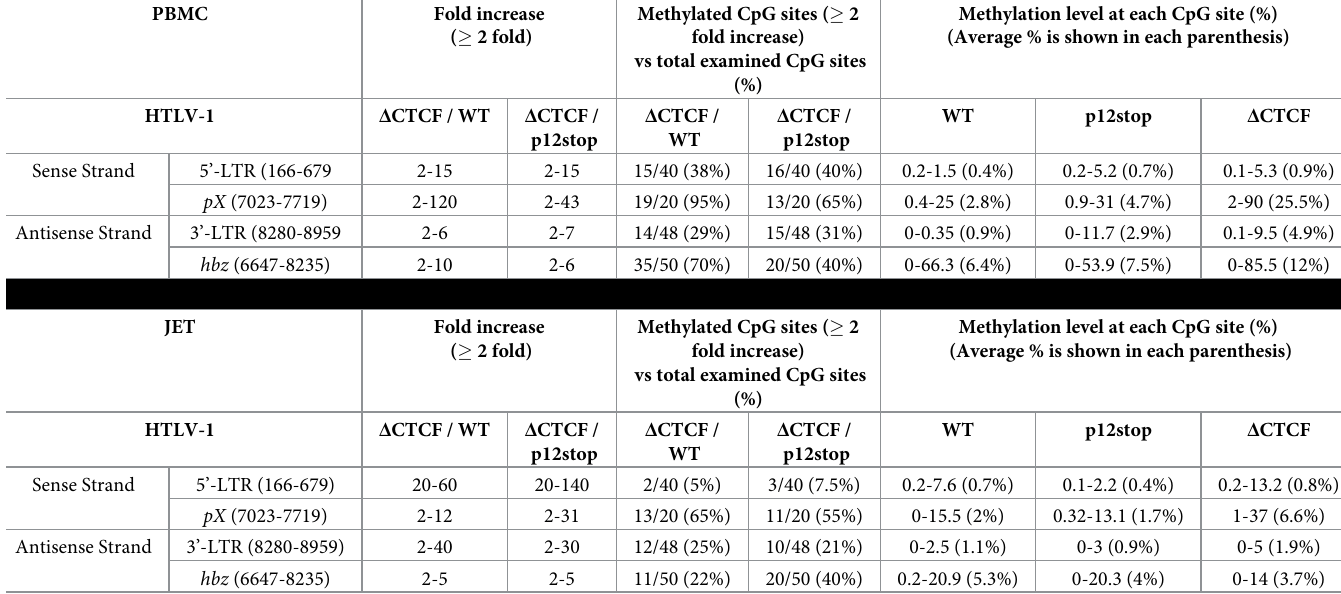
Table 1. Summary of increased methylation in 5’LTR, env , pX region (sense) and 3’LTR/ hbz (antisense) of HTLV-1 Δ CTCF compared to wild type HTLV-1 or HTLV-1p12stop. PBMC Fold increase Methylated CpG sites ( � 2 ( � 2 fold) fold increase) vs total examined CpG sites (%)